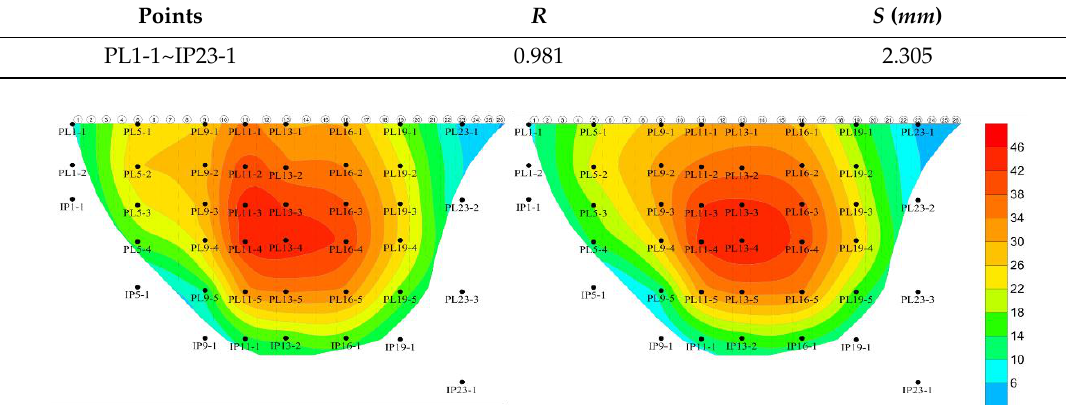
Table 10. Correlation coe ffi cient and residual standard deviation of spatiotemporal hybrid model. Points